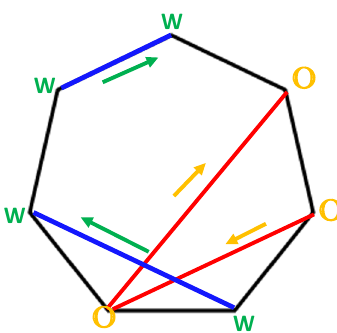
Figure 7 . The clockwise oriented heptagon for octonion multiplication in Cartan-Schouten-Coxeter convention (4.2). We start at the second right octonion O and call it e r +1 , we get the 7 associative triads in the form as ( r +1 , r +3 , r +7) . The complimentary quadruples are ( r +2 , r +4 , r +5 , r +6) . They are shown at the corners with the oriented clockwise blue lines. These give WO clockwise oriented